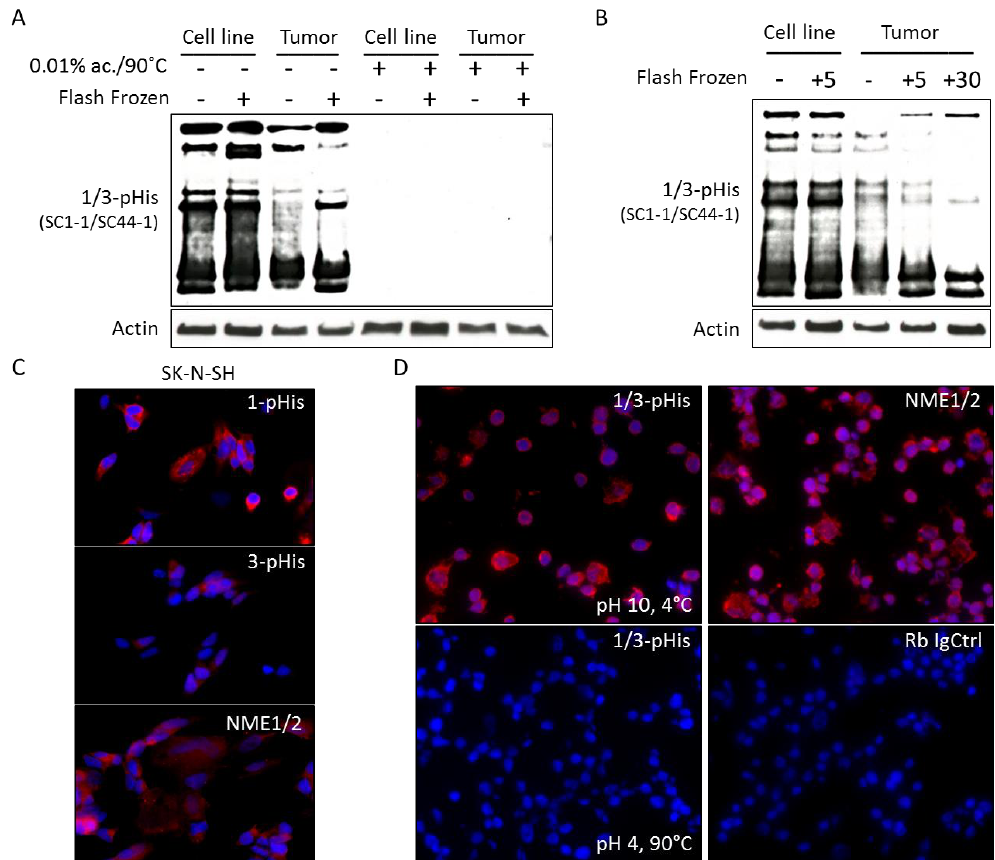
Figure 3. Histidine phosphorylation in neuroblastoma cell lines and tumor samples. ( A ) Immunoblots of neuroblastoma cell lysates and xenograft tumor lysates generated immediately after harvesting or after freezing in liquid N 2 for 1 / 3-pHis and actin are shown, comparing conditions where pHis is preserved (pH 10, 4 ◦ C) and where it is lost (pH 3 (0.01% acetic acid), 90 ◦ C). ( B ) Immunoblots of neuroblastoma cell lines lysed immediately after harvesting or after a 5-min delay ( + 5) and of orthotopic neuroblastoma tumor samples lysed immediately after harvesting or after 5 ( + 5) and 30 ( + 30) minute delays were performed with antibodies to 1 / 3-pHis and actin. ( C ) Immunofluorescence images using antibodies to 1 / 3-pHis and total NME1 / 2 labeled with Alexa Fluor 568 (red) in SK-N-SH neuroblastoma cells are shown. ( D ) Immunofluorescence images using antibodies to 1 / 3-pHis and NME1 / 2 in sections of SK-N-SH neuroblastoma cells from the optimal cutting temperature (OCT) block. Combined 1- and 3-pHis, NME1 / 2 and rabbit IgG (Rb IgG Ctrl) were tested, comparing conditions where pHis is preserved (pH 10, 4 ◦ C) and where it is lost (pH 4, 90 ◦